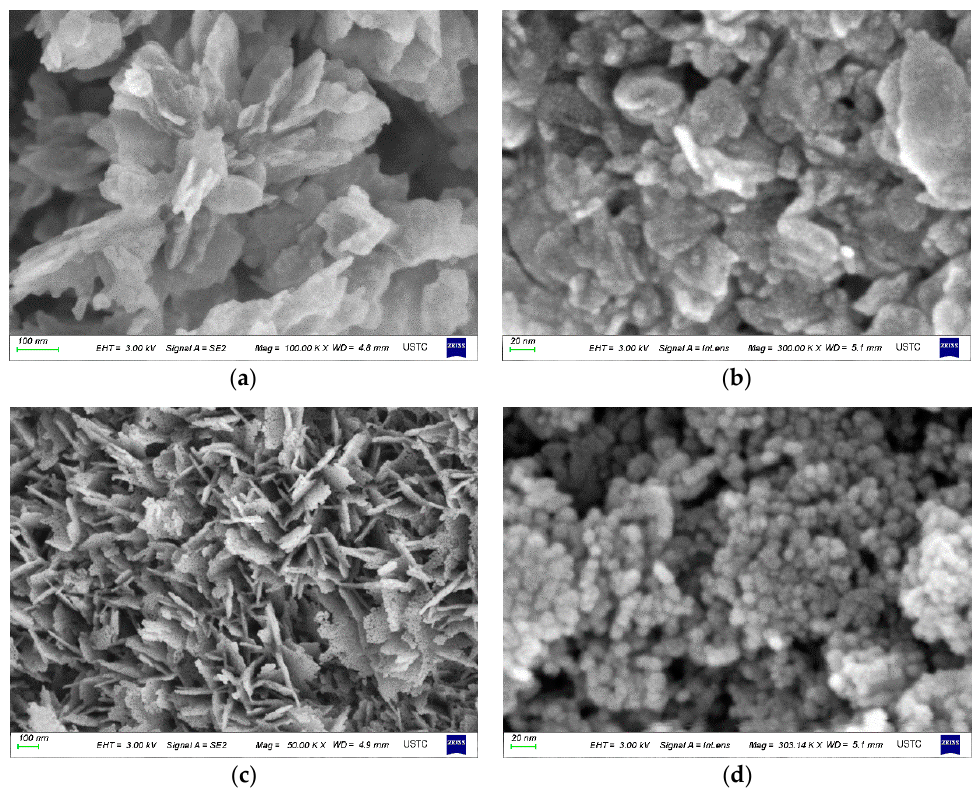
Figure 2. ( a ) Untreated basic zinc carbonate (precursor); ( b ) after ball milling the precursor for 600 min; ( c ) after calcination of the precursor at 300 °C; and ( d ) after ball milling the precursor for 600 min, followed by 300 °C calcination.